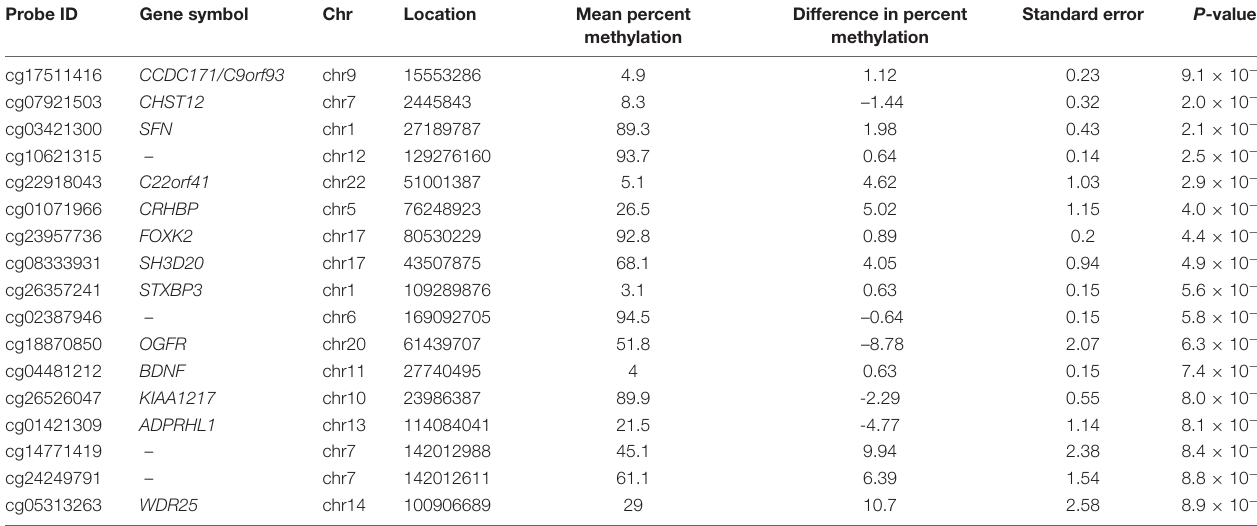
TABLE 2 | Cord blood DNA methylation loci associated ( P -value < 1 × 10 − 4 ) with ASD diagnosis at 36-months, adjusting for surrogate variables. Probe